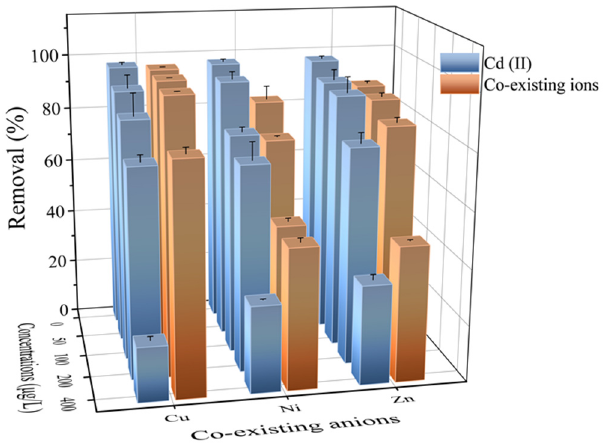
Figure 5. Cd (II) adsorption in the presence of co-existing anions, such as Cu (II), Ni (II), and Zn (II) (from 50 to 400 μ g·L − 1 ) and the removal of co-existing anions by Fe 3 O 4 @PB.